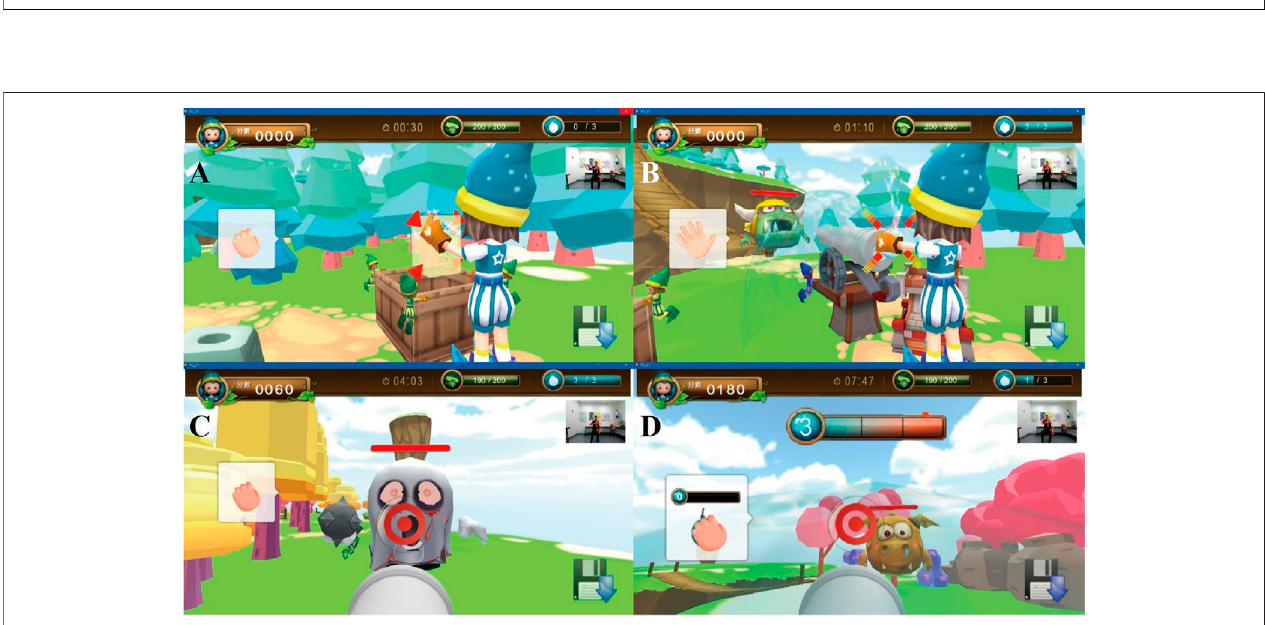
FIGURE 1 | The game screen and the feedback during the gameplay. (A) A participant playing our Kinect game with a Kinect skeleton tracker. (B) The visual feedbackontheupperlimbmovementsoftheplayer(Knowledgeofperformance). (C) Theperformancescoreduringgameplayasanotherformoffeedback(Knowledge of results).